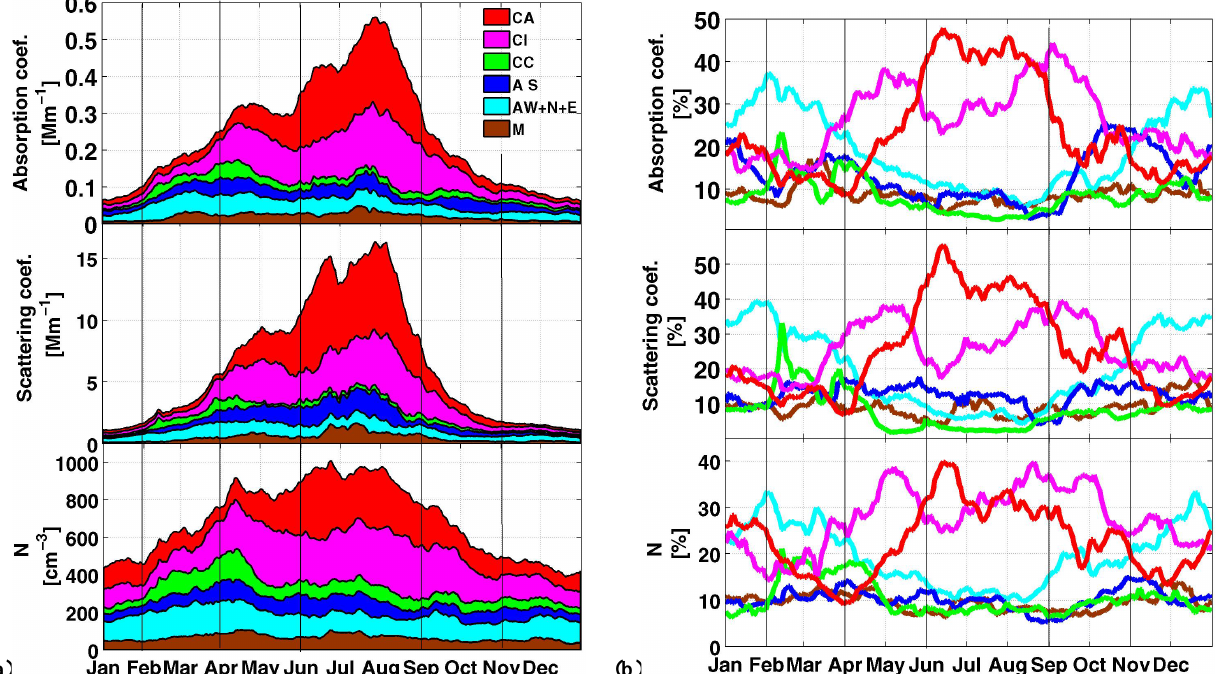
Fig. 5. Median 1995–2008 annual cycles of the absorption coefficient at λ =880nm, the scattering coefficient at λ =550nm and the aerosol number concentration as a function of SYNALP weather types: (a) summed contributions of each weather type as a function of the measured variables during each weather type and its frequency of occurrence, (b) relative contributions of each weather type in %.